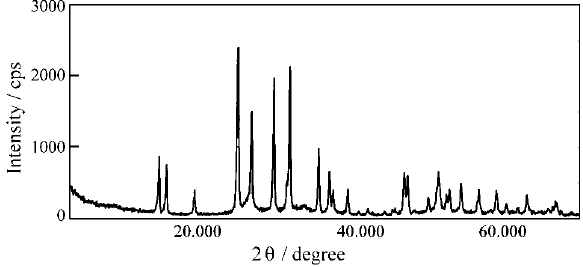
Figura 6c. Difractograma de rayos X de la muestra sólida obtenida a pH 10 de la disolución 0.2 M de SnCl 2 .